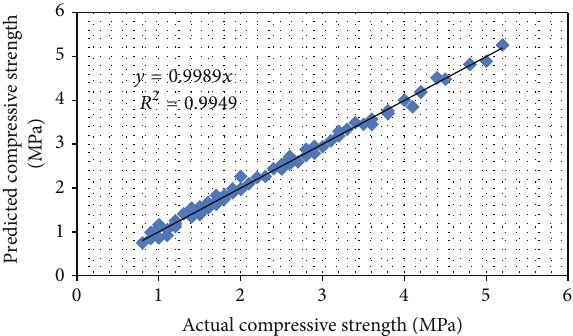
Figure 10: Performance of the density by nonlinear regression